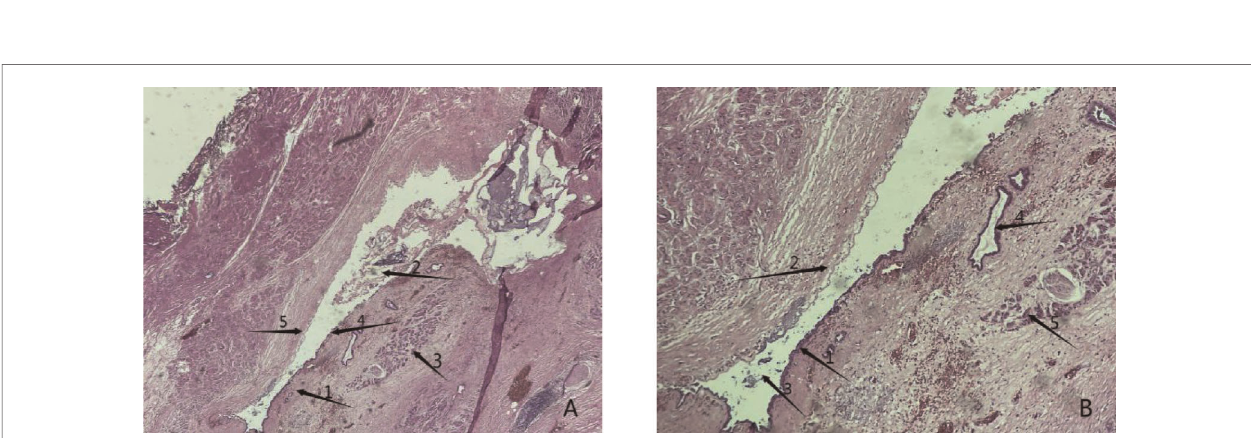
FIGURE 3 | Intraoperative images. ( A, B ) A small amount of uncoagulated blood observed in the abdominal cavity after creating an incision in the peritoneum incision. ( C ) Hematocele below the hepatic margin observed during intraoperative exploration. ( D ) A dark blood clot in the posterior peritoneum of the duodenum.